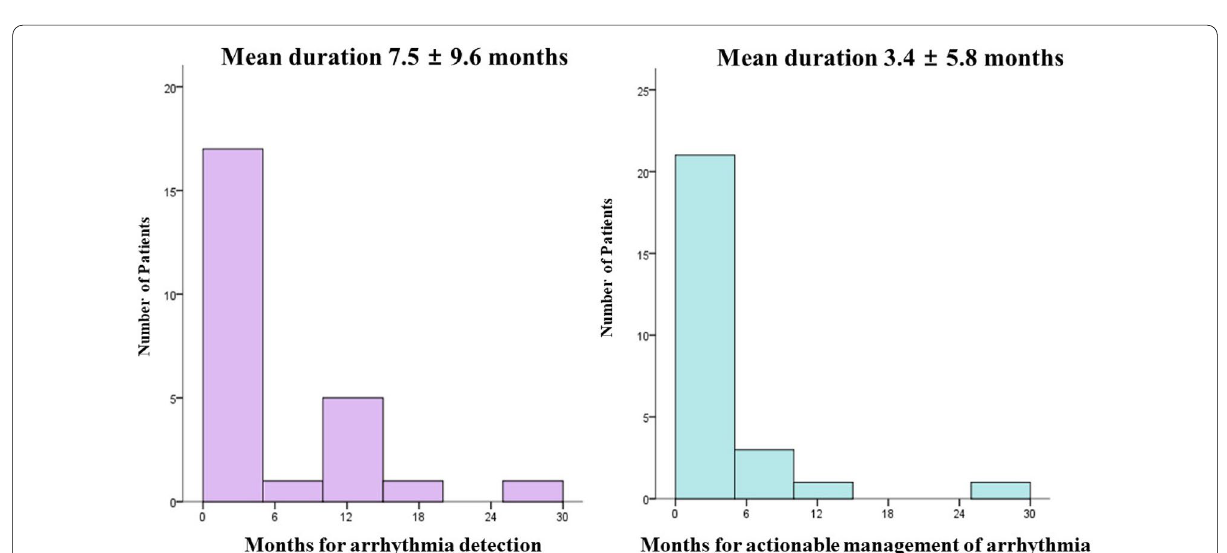
Fig. 3 Time duration for the detection and treatment of arrhythmia. The histograms show the mean duration of time from implantation of the loop recorder to the diagnosis of arrhythmias and the mean duration from arrhythmia detection to treatment